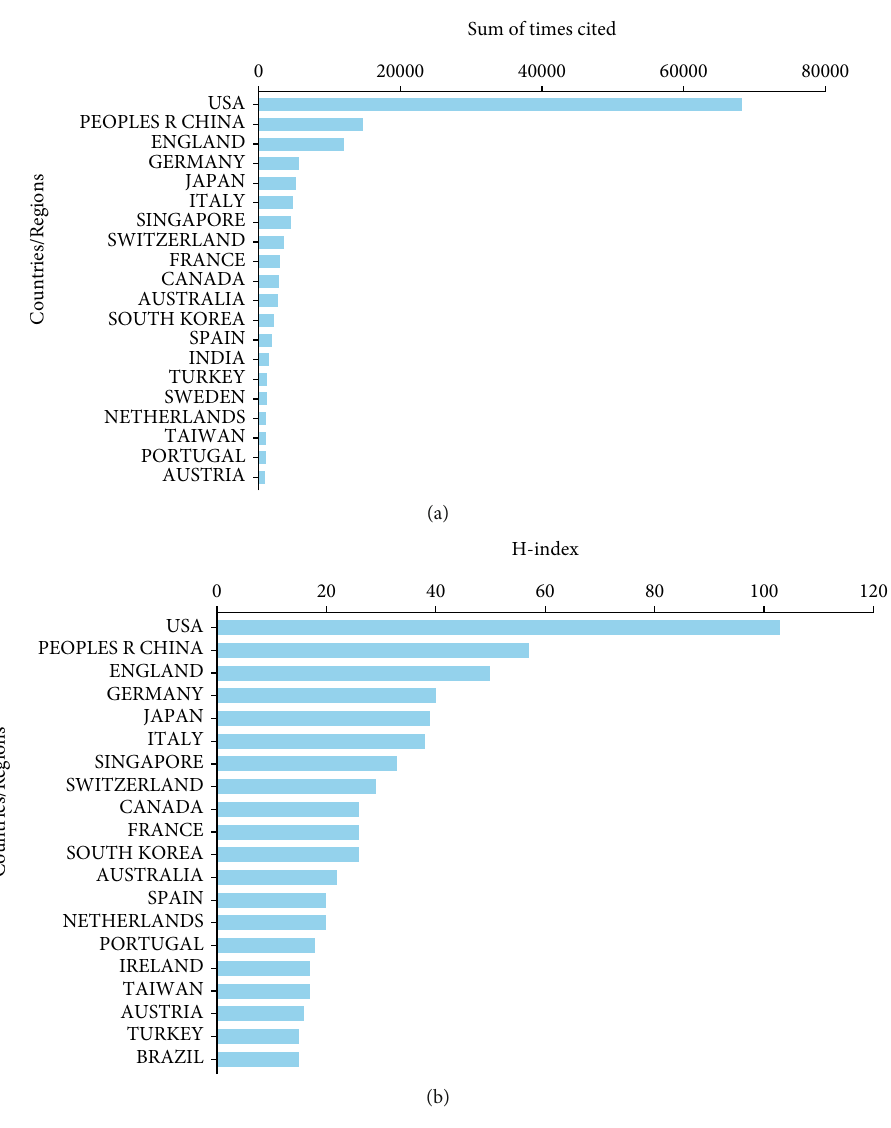
Figure 2: (a) The top 20 countries of total citations. (b) The top 20 countries of H -index of